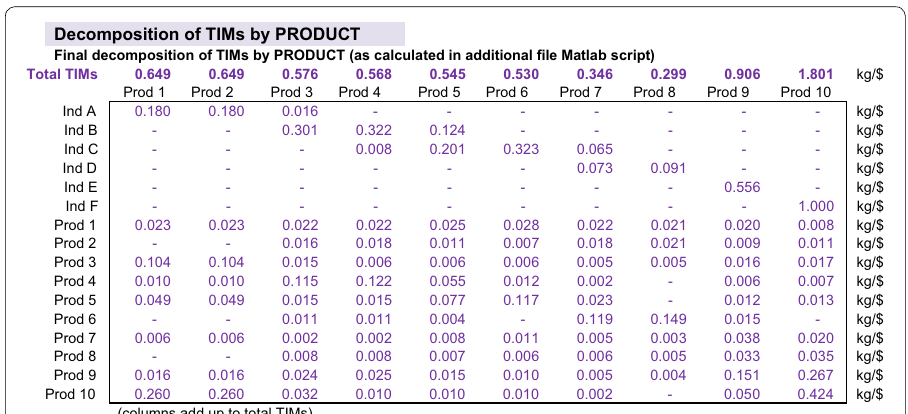
Fig. 4 Final stage of product TIM decomposition by product (matrix M p ). Contributions from industries repre- sent ‘own’ impacts from the industry (or industries) that produce the